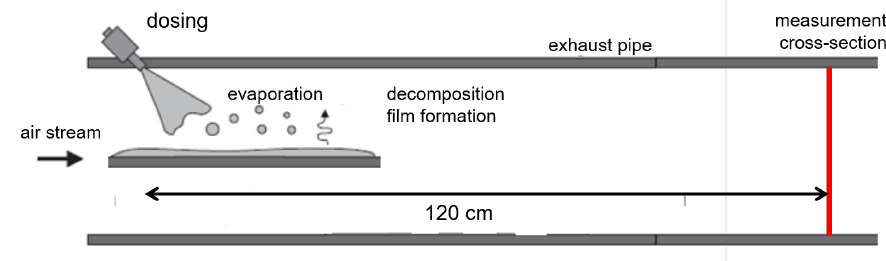
Figure 9. Experiment 1: UWS injection on a hot flat plate within the exhaust